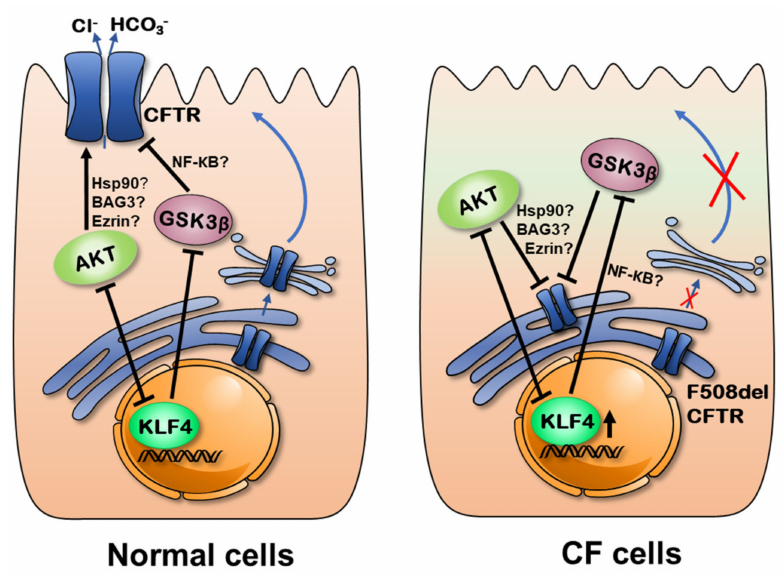
Figure 6. KLF4 acts as a negative regulator of wt-CFTR but has its function disrupted in the F508del–CFTR cells. Our data suggest that the AKT pathway is a positive regulator of wt-CFTR while being a negative regulator of F508del–CFTR in a way that is possibly at least partially mediated by KLF4, which in turn seems to be negatively regulated by AKT signaling in wt-CFTR cells. GSK3 β , on the other hand, seems to be a negative regulator of CFTR, which is KLF4-dependent in wt-CFTR and KLF4-independent in F508del–CFTR expressing